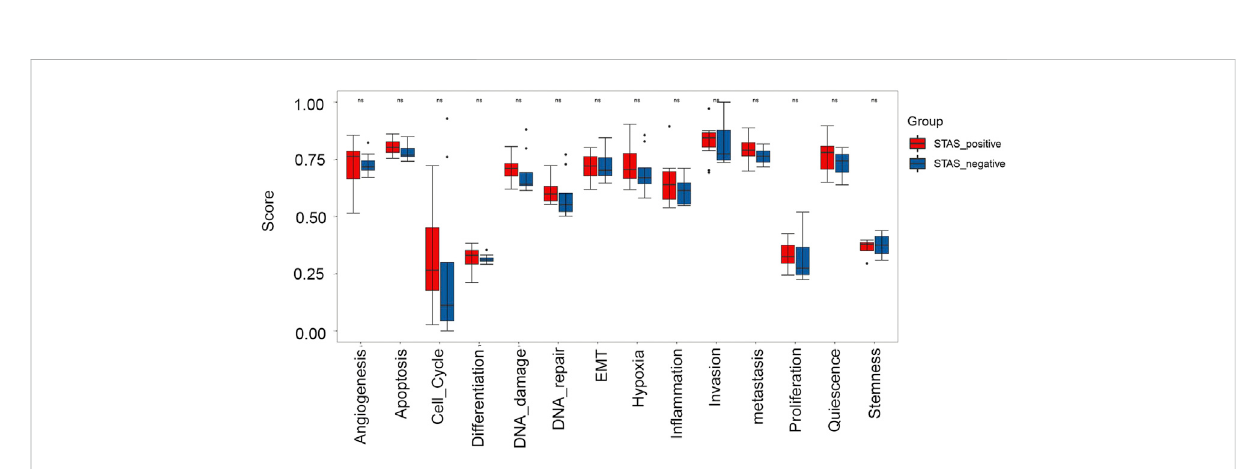
FIGURE 8 Box plot analysis of 14 functional status features between STAS_positive and STAS_negative